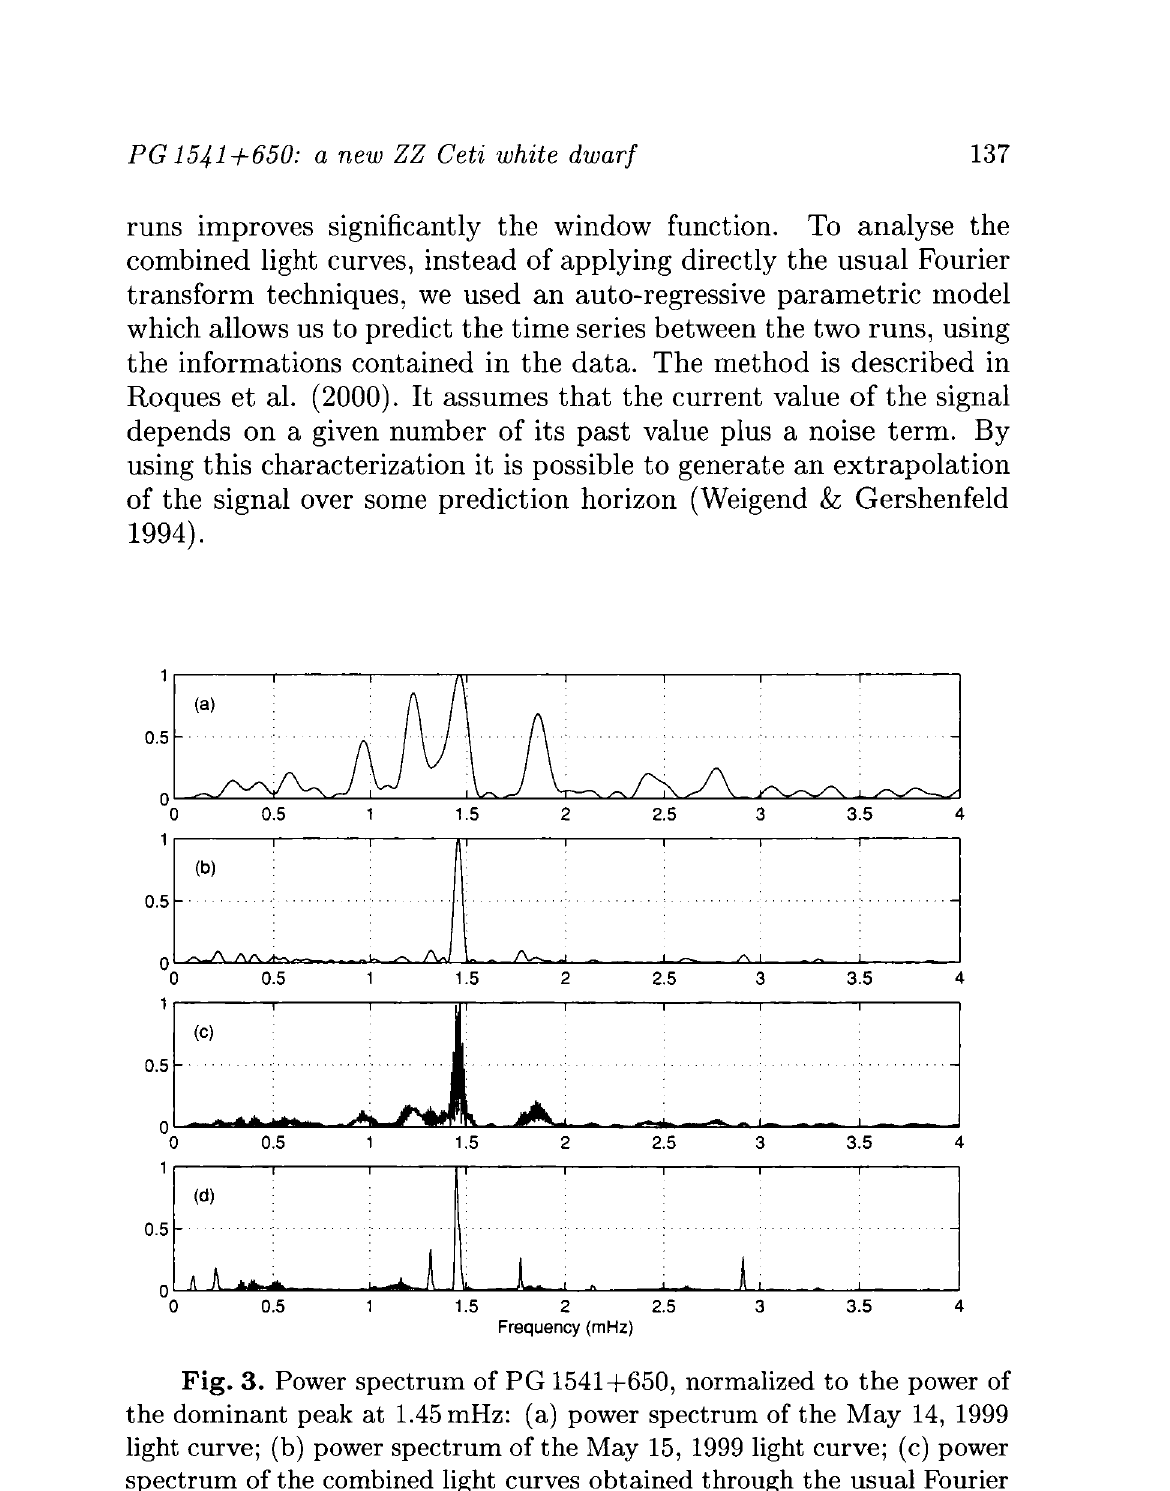
Fig. 3. Power spectrum of PG 1541+650, normalized to the power of the dominant peak at 1.45 mHz: (a) power spectrum of the May 14, 1999 light curve; (b) power spectrum of the May 15, 1999 light curve; (c) power spectrum of the combined light curves obtained through the usual Fourier Transform techniques; (d) power spectrum of the combined light curves obtained by using the auto-regressive parametric